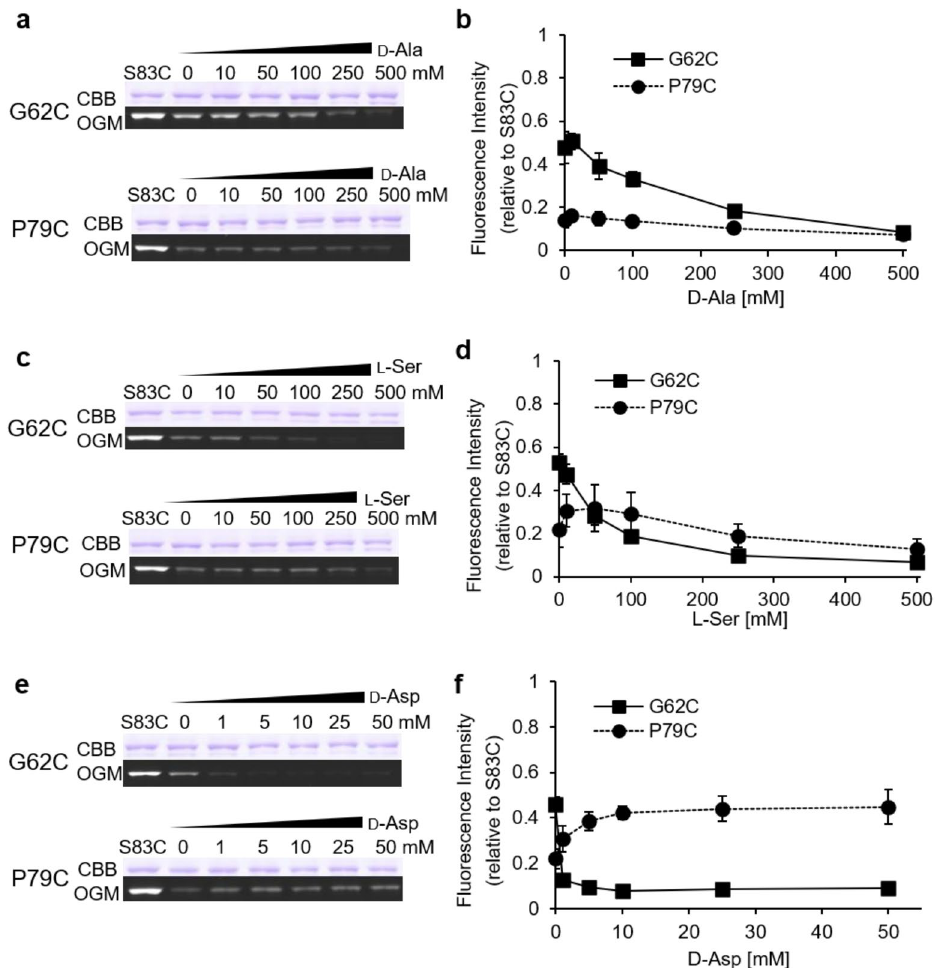
Figure 2. Conformational changes induced by substrate analogs. G62C ( ■ ) and P79C ( ● ) were exposed to OGM in the absence or presence of d-Ala ( a and b ), l-Ser ( c and d ), or d-Asp ( e and f ). Purified proteins from OGM-exposed E. coli cells were analyzed by using non-reducing SDS-PAGE as described in the legend to Fig. 1. The original gels are presented in Supplementary information Fig.